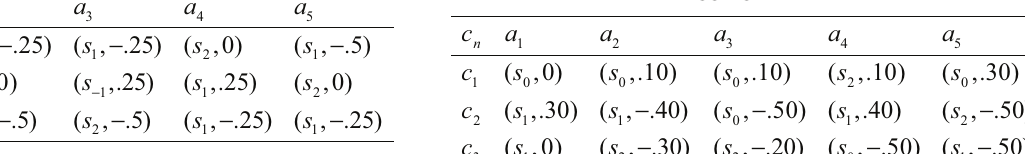
Table 10. Decision matrix of